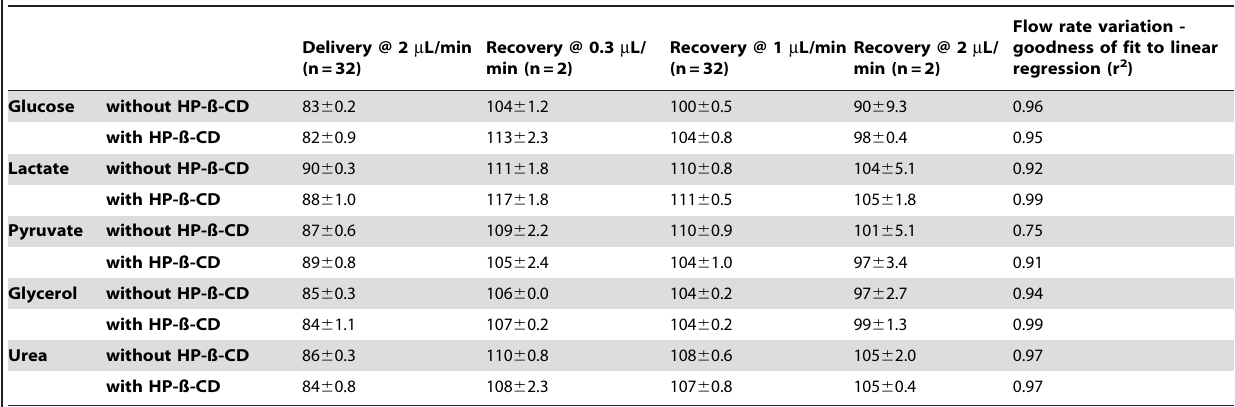
Table 1. In vitro metabolite delivery and recovery rates (%) at different perfusion rates (after 20 min equilibration time, mean 6